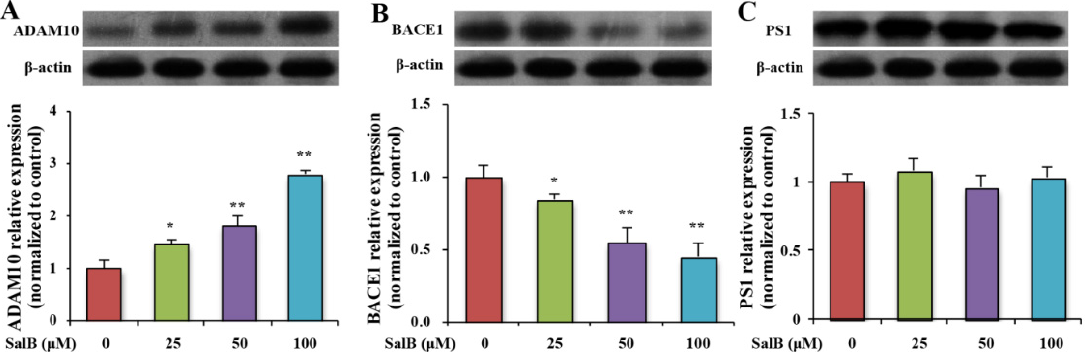
Figure 4. Effect of SalB on the protein expression of ADAM 10, BACE1 and PS1 in SH-SY5Y-APPsw cells. The protein expressions of ADAM 10 ( A ); BACE1 ( B ) and PS1 ( C ) were determined in SH-SY5Y-APPsw cells. Values are expressed as the mean ± SD in each group ( n = 3). * p < 0.05, ** p < 0.01 vs. control. SalB: Salvianolic acid B.